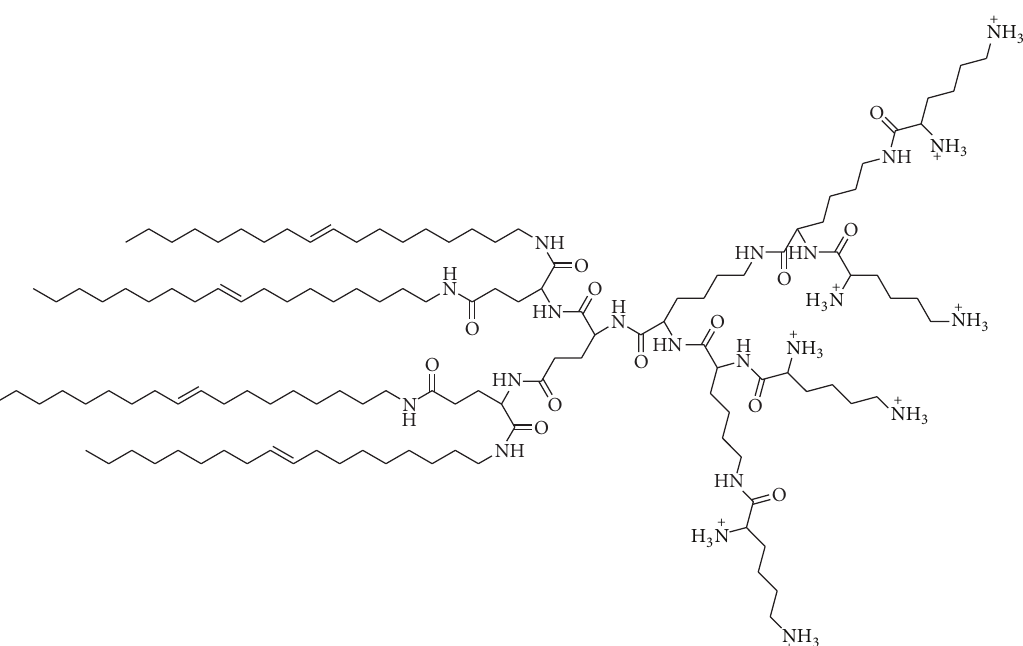
Figure 9: Tetra-oleoyl lysine (TOL) G3